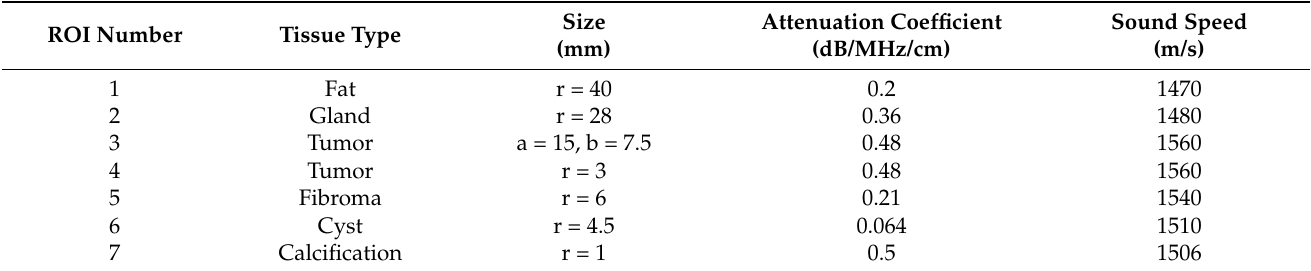
Figure 7. Ultrasonic imaging system model. Table 3. Parameters of breast phantom.